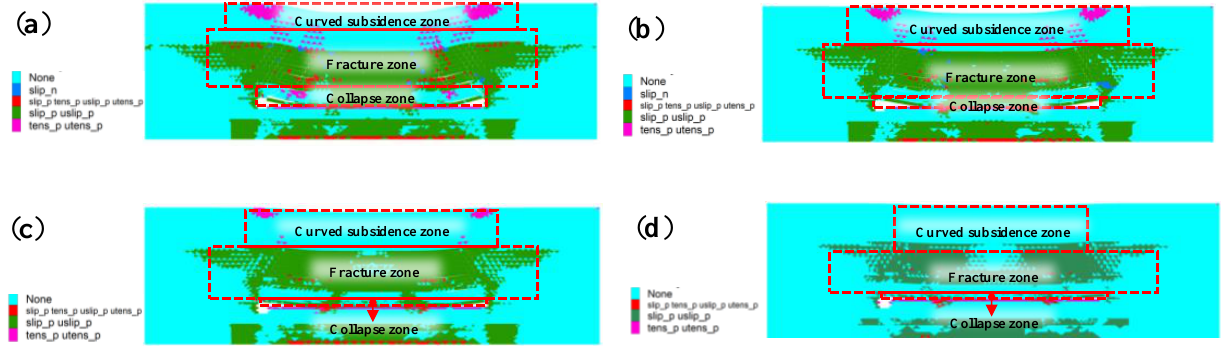
Figure 8. ( a ) Plastic zone diagram with a filling rate of 20%. ( b ) Plastic zone diagram with a filling rate of 40%. ( c ) Plastic zone diagram with a filling rate of 60%. ( d ) Plastic zone diagram with a filling rate of 80%.